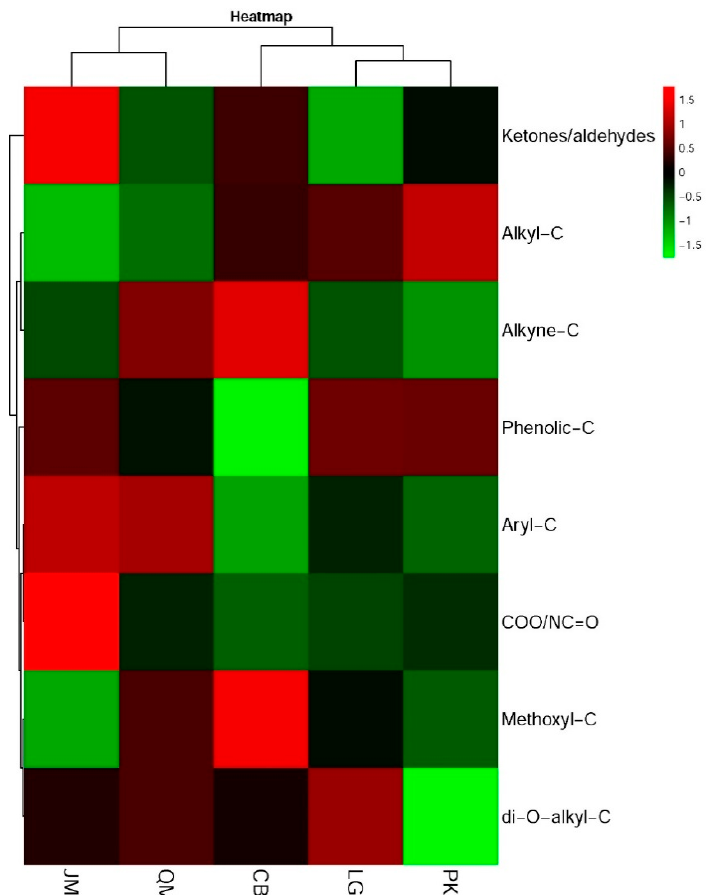
Figure 3. A principal component analyses (PCA) combined ordination plot performed on relative abundance of 7 C functional groups across different revegetation types. JM: Juglans mandshurica ; QM: Quercus mongolica ; CB: Conifer-broadleaf forest; LG: Larix gmelinii ; PK: Pinus koraiensis .